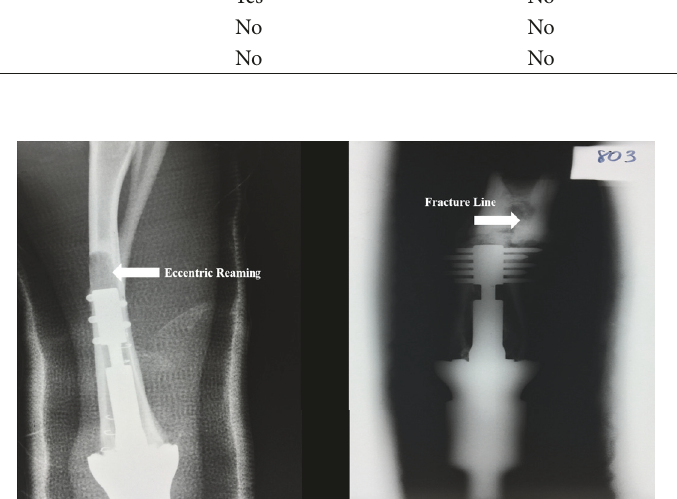
Figure 3: Two animals sustained fractures of their radius after the first surgery. It was presumed that eccentric reaming (left) due to the bow of the radius created a stress riser and resultant spiral type fracture